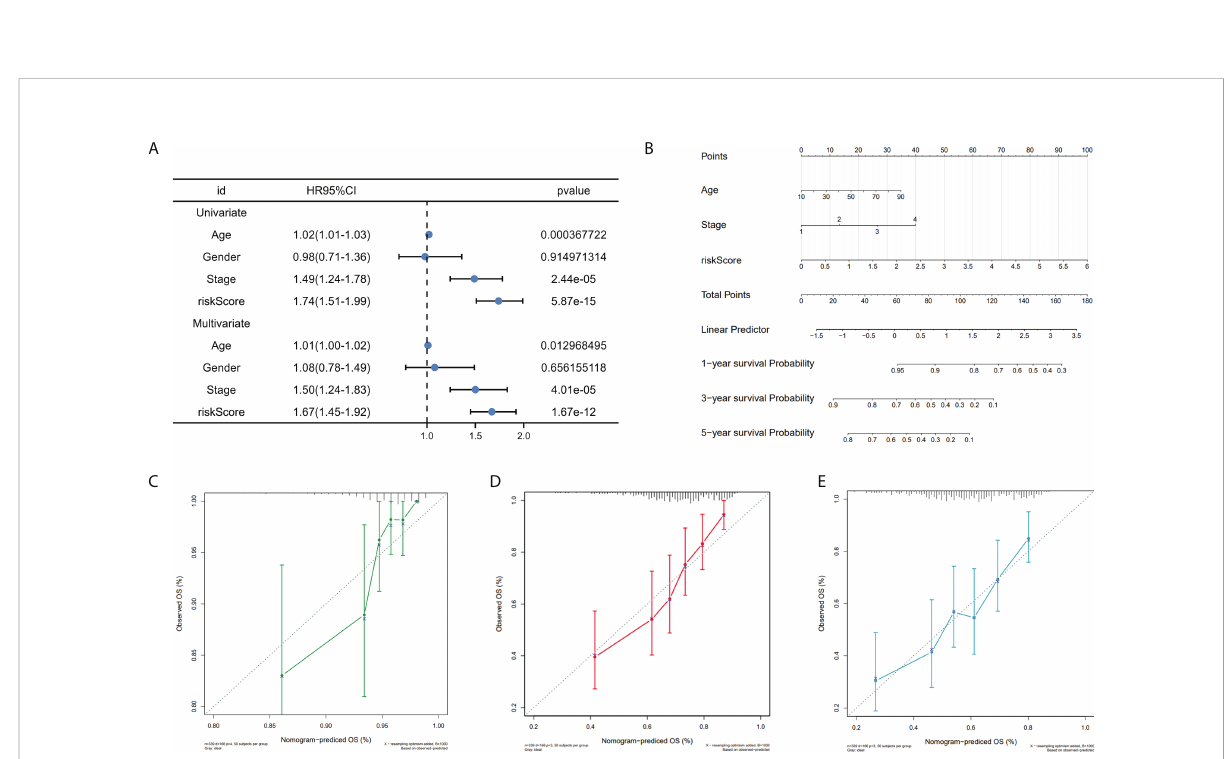
FIGURE 6 Nomogram construction. (A) Univariate and multivariate cox regression prognostic markers. (B) Nomogram predicting SKCM patients ’ 1-, 3-, and 5-year OS. (C-E) . Calibration curves for 1-, 3-, and 5-year patient